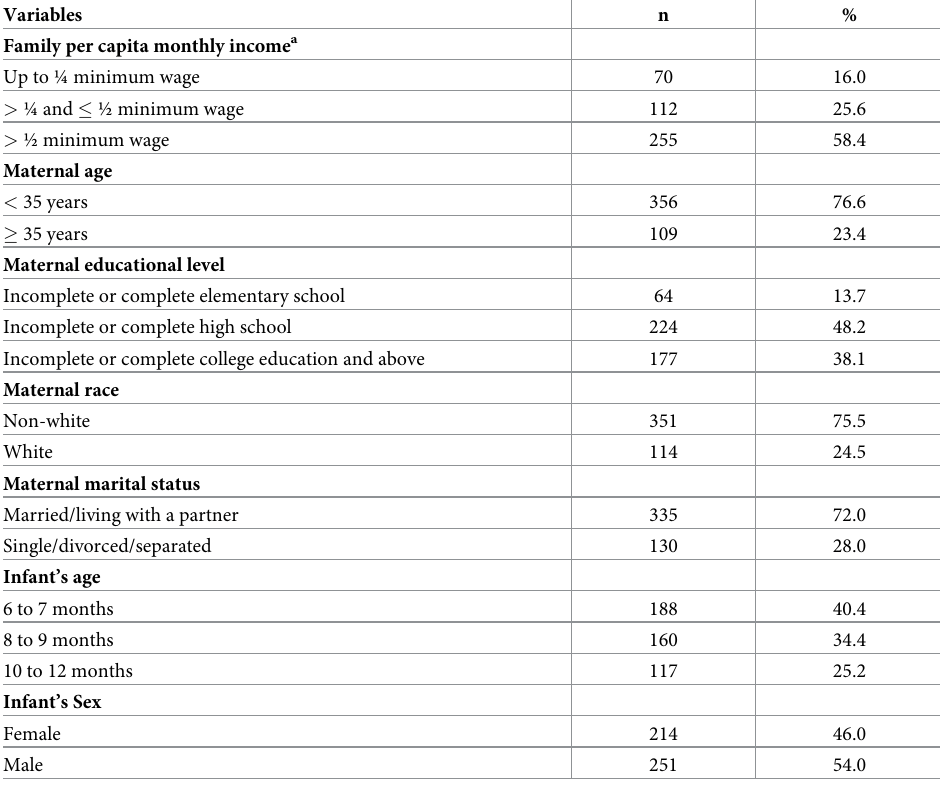
Table 1. Descriptive analysis of the 465 mother-infant pairs participating in the Brazilian Portuguese version of the Infant Feeding Style Questionnaire (IFSQ-Br) validation. Federal District, Brazil. 2018. Variables n % Family per capita monthly income